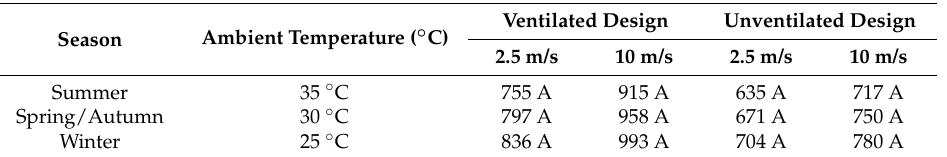
Table 6. Continuous ratings in different